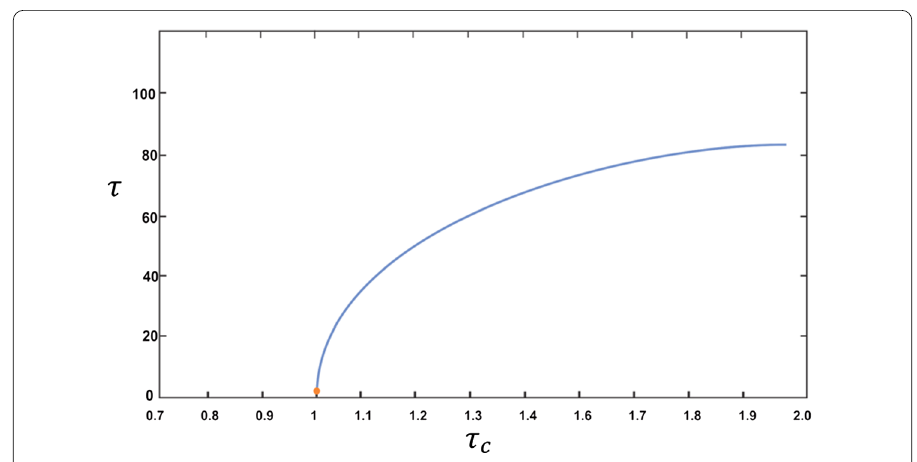
Figure 2 Demonstration of the forward bifurcation process of the model with τ against τ c : where τ c = q ω c , ω c = 0.024, P = 1000, q = 2200, E 1 = 0.029 and E 2 =